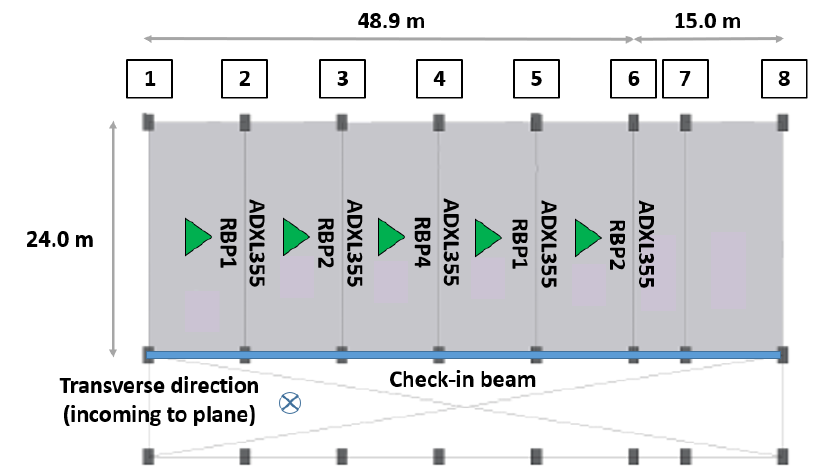
Figure 7. Experimental setup of the beam demolition